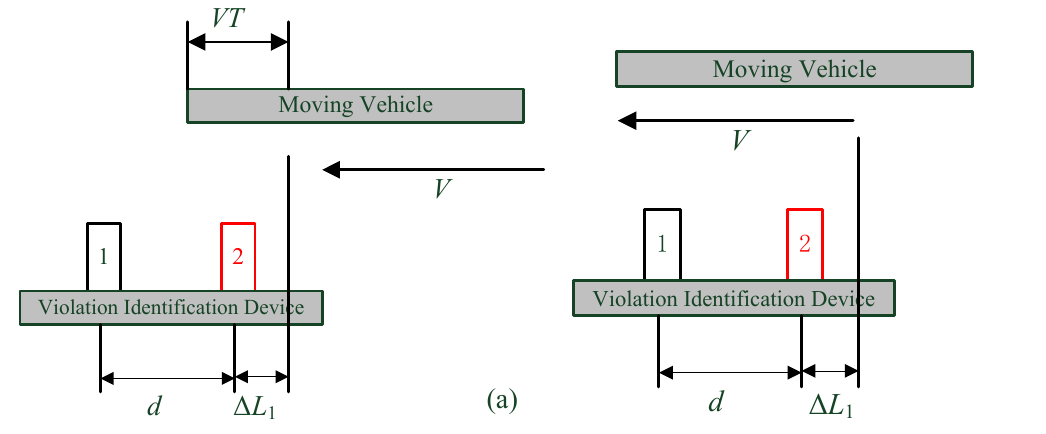
Figure 11. Vehicle has just entered the measurement range: ( a ) Detected by sensor 2 only; ( b ) Detected by both sensors.